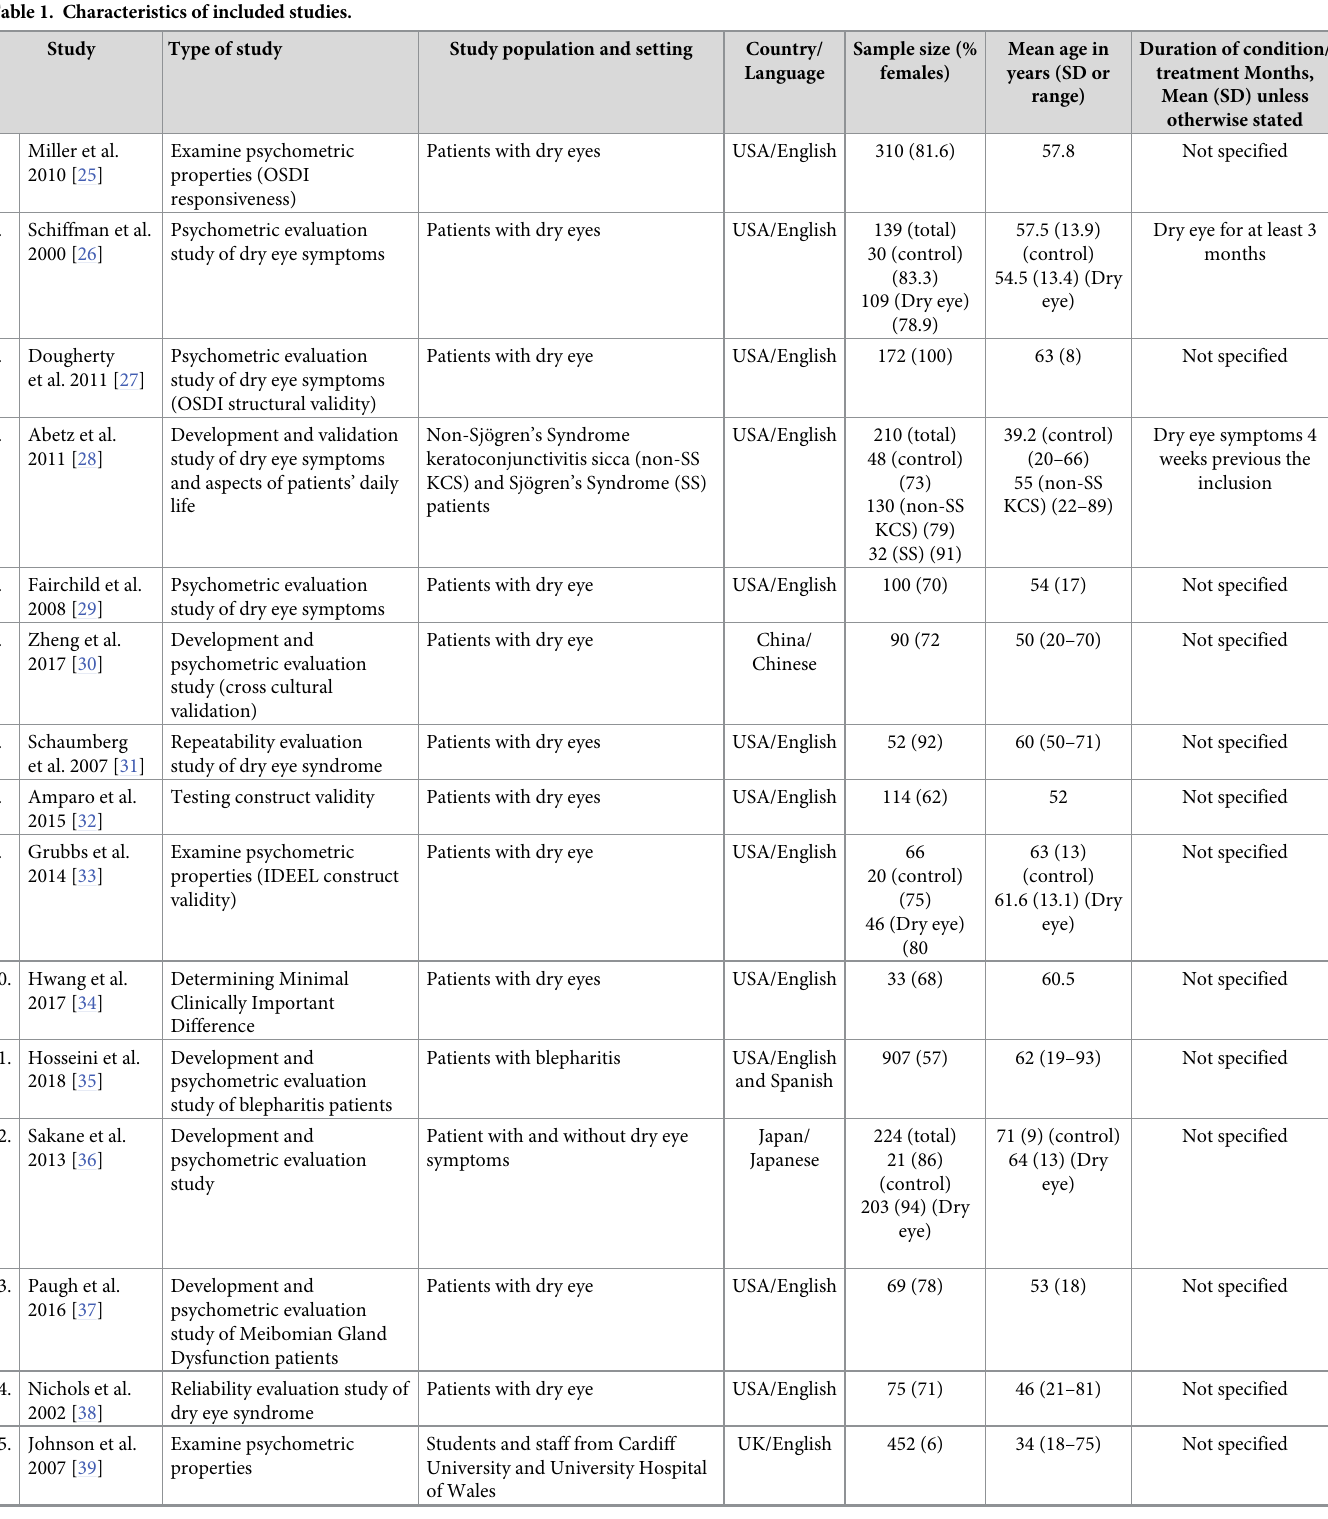
Table 1. Characteristics of included